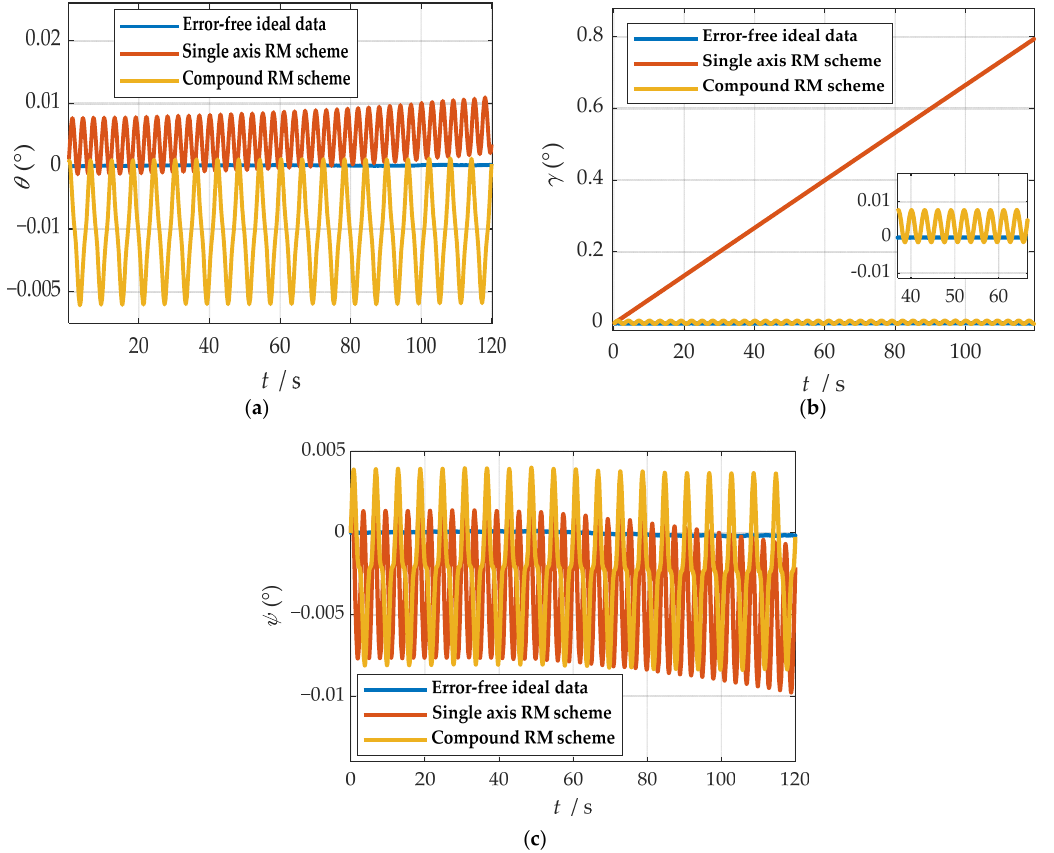
Figure 8. Comparison of attitude solution results: ( a ) comparison of calculation results of yaw angle; ( b ) comparison of calculation results of roll angle; ( c ) comparison of calculation results of pitch angle.